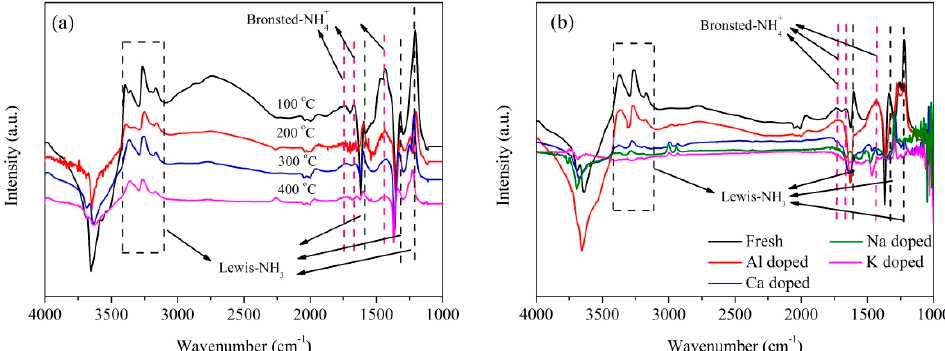
Figure 9. NH 3 -DRIFTS spectra of ( a ) fresh 1V-5W/Ti and ( b ) 1 M doped catalysts (M = Al, Ca, Na, and K).